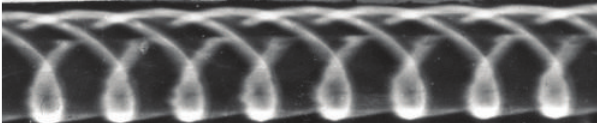
Figure 8: Typical streak records of self-luminosity of steady rotating DWs in circle combustion channel at registration along axis (radial mixture flow, three rotating waves on channel circuit).